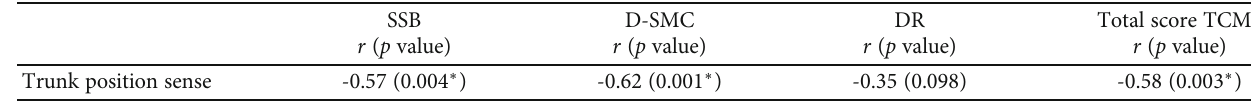
Table 3: Correlation between trunk position sense and TCMS ( n = 24 ).